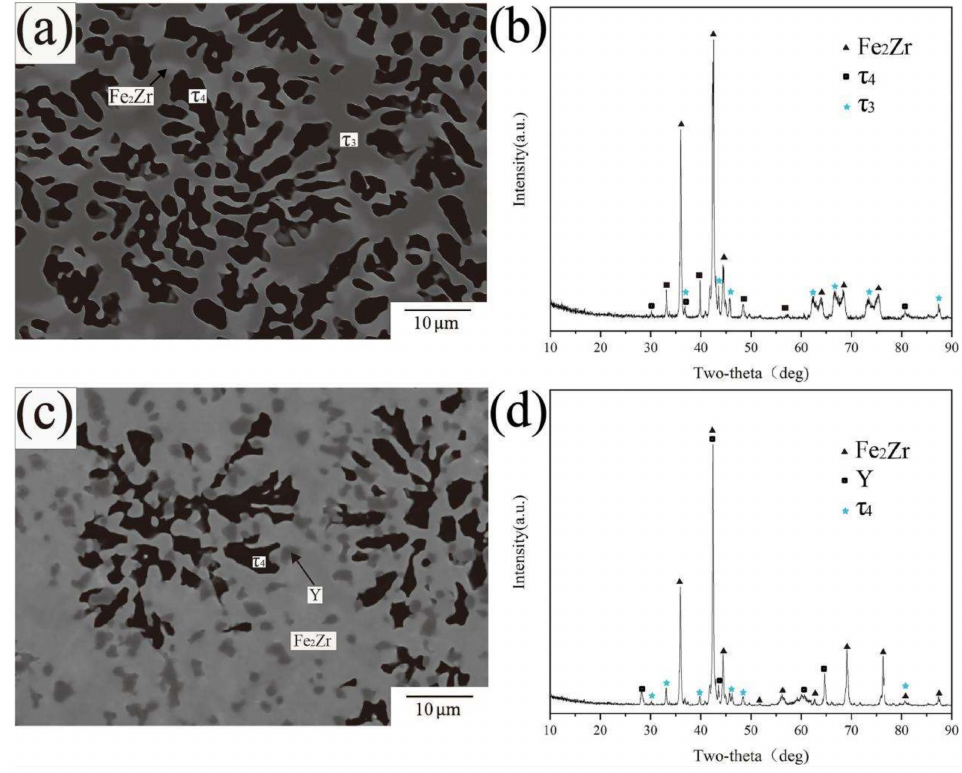
Figure 8. ( a ) BSE image of A2 ( b ) XRD pattern of A2 ( c ) BSE image of A9 ( d ) XRD pattern of